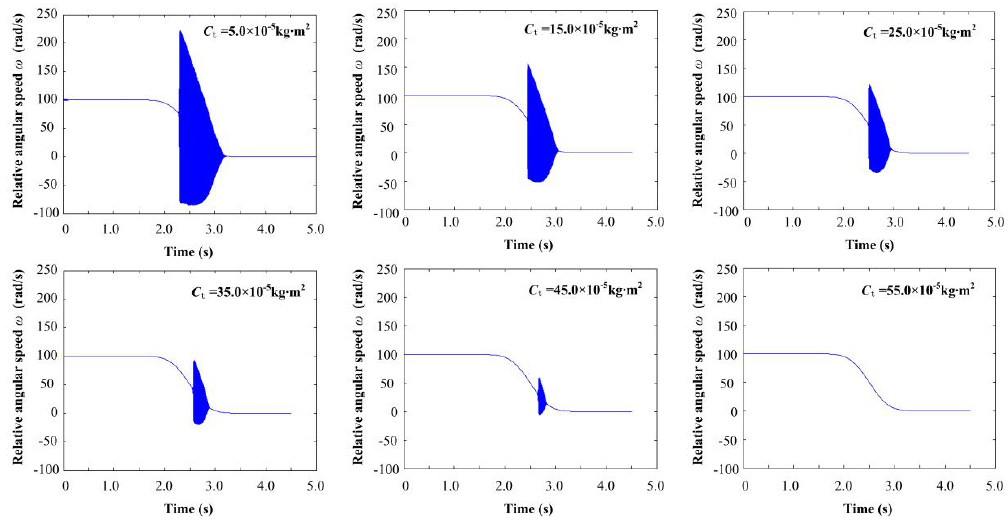
Figure 18. The relative angular speed ω during shaft deceleration.